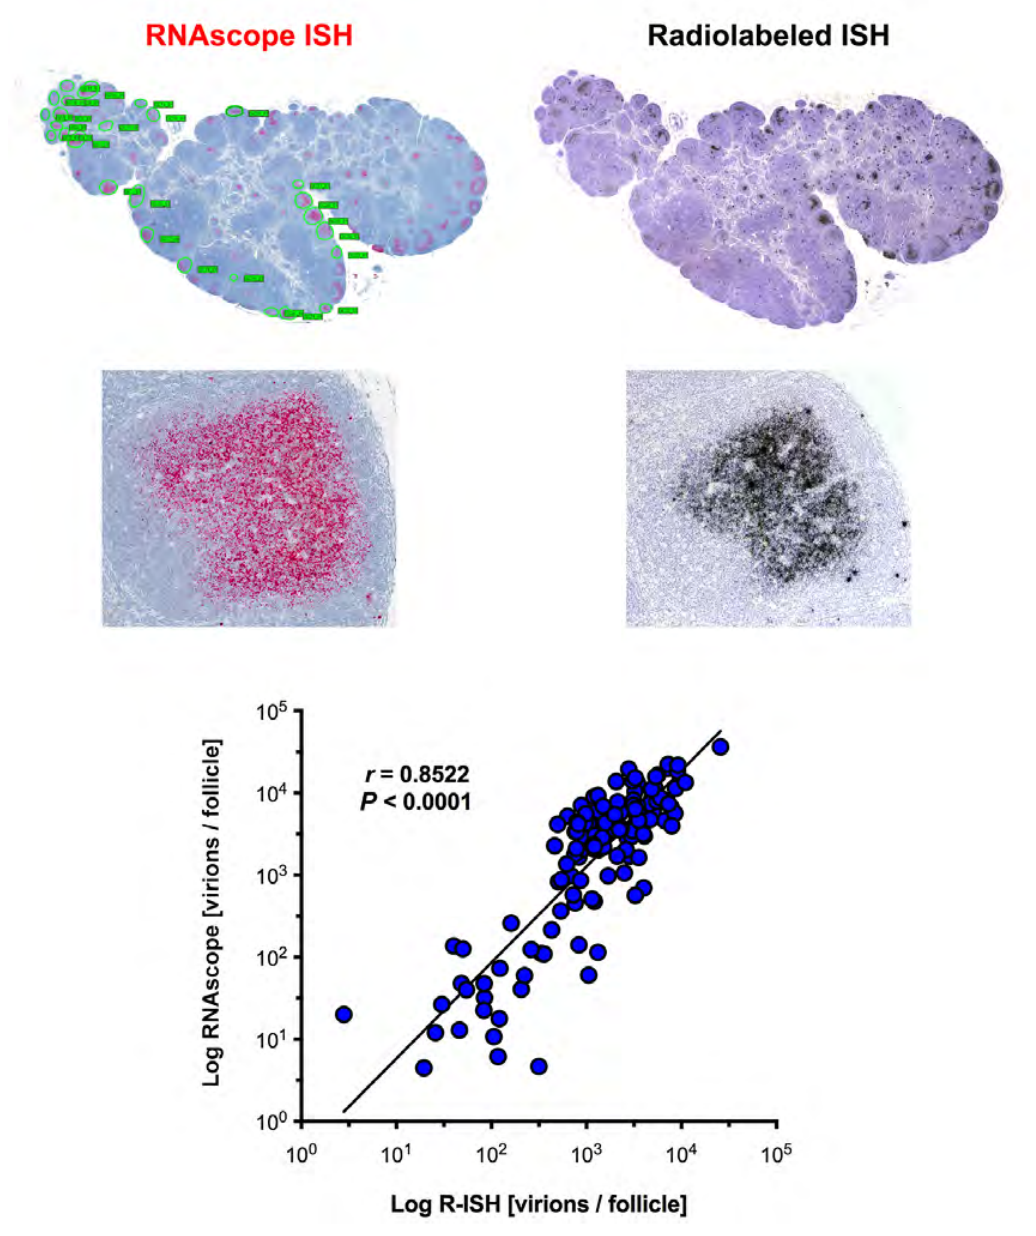
Supplemental Figure 1. Comparison of RNAscope and R-ISH approaches for detection of viral par- ticles in B cell follicles. Representative subjacent whole lymph nodes (LN) sections (top panel) and high magnification (lower panel) images showing SIV vRNA expression following RNAscope (left panel) and radiolabeled (right panel) in situ hybridization (ISH). Viral particles were quantified from 163 mapped B cell follicles in 3 subjacent lymph node tissue sections from 3 chronically SIV+ RMs. There is a strong cor- relation between the enumerated virions quantified by R-ISH and RNAscope ISH in B cell follicles. Quan- tified values were log10 transformed and P values were based on associations between paired comparisons using the Pearson’s Correlation